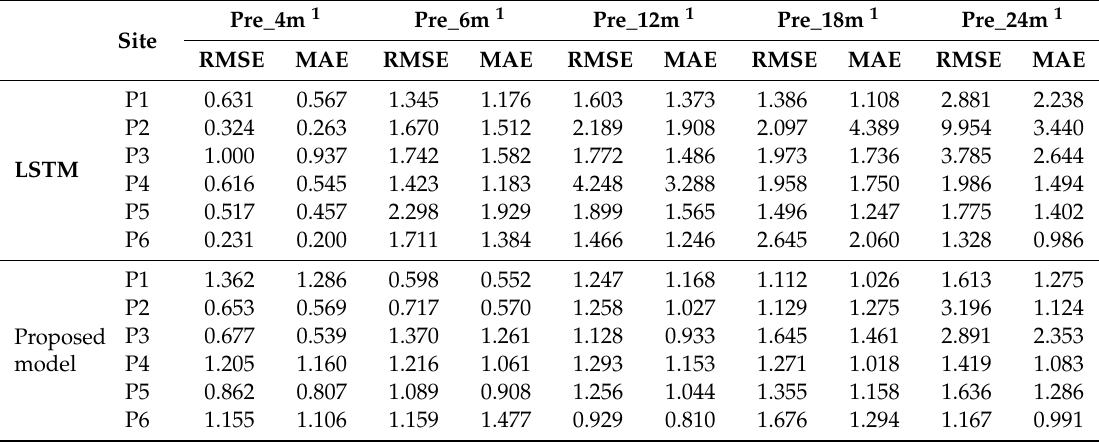
Table 2. Monthly RMSE and MAE of six sites with di ff erent predicted lengths (the unit is ◦ C).